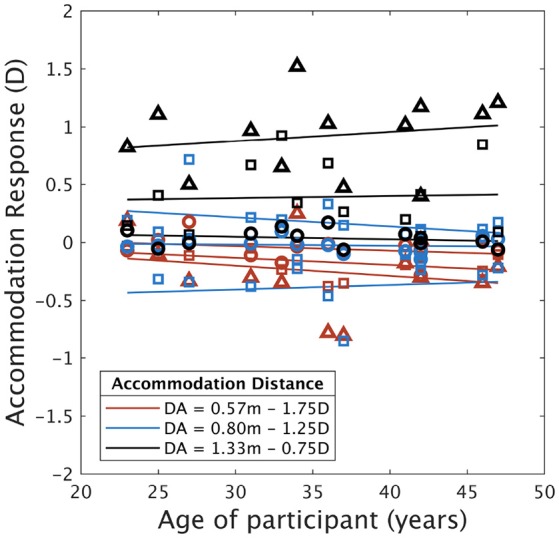
Accommodation responses as a function of participant's age (sorted in ascending order) for each accommodation distances (royal blue: 0.57 m, cadet blue: 0.80 m, and medium green: 1.33 m; conflict is represented by circles: 0 D, squares: ± 0.5 D, and triangles: ± 1 D). Lines represent linear regression fit for each set of distances. Negative values refer to disaccommodation, while positive values refer to accommodation.